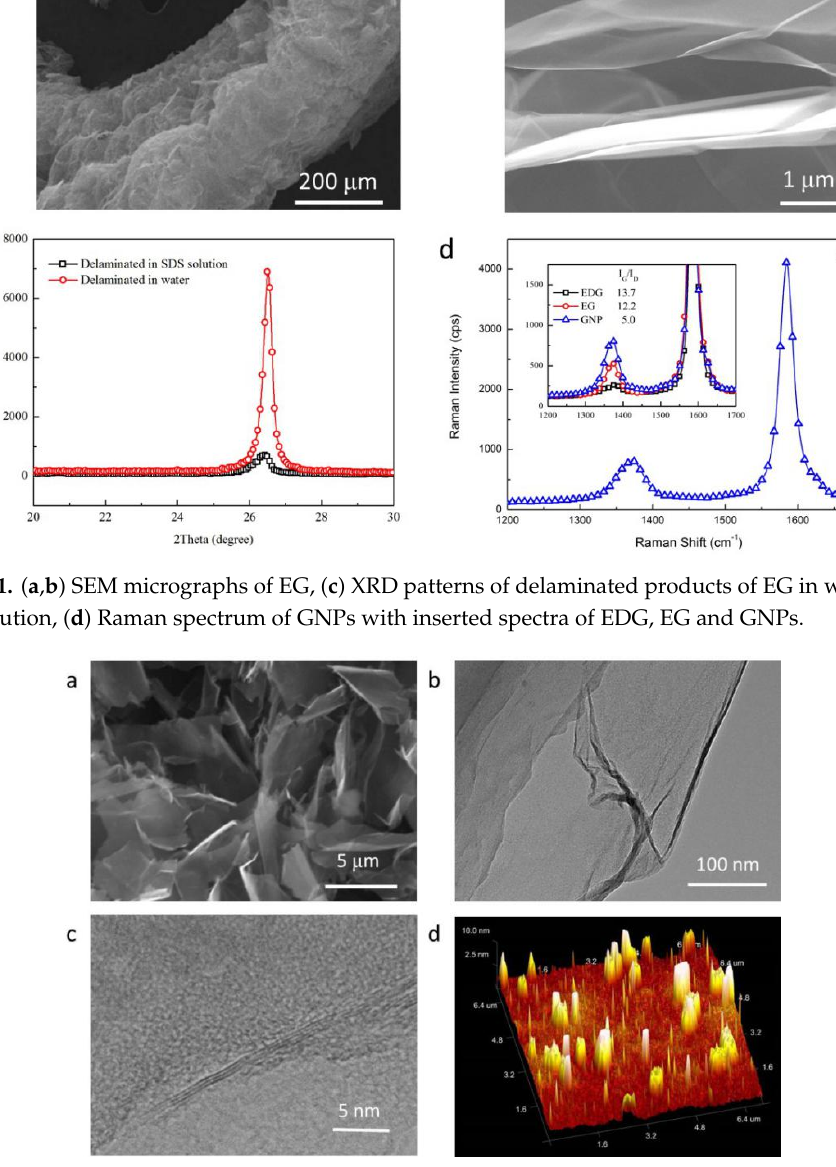
Figure 2. ( a ) SEM, ( b , c ) TEM, and ( d ) AFM micrographs of GNPs.